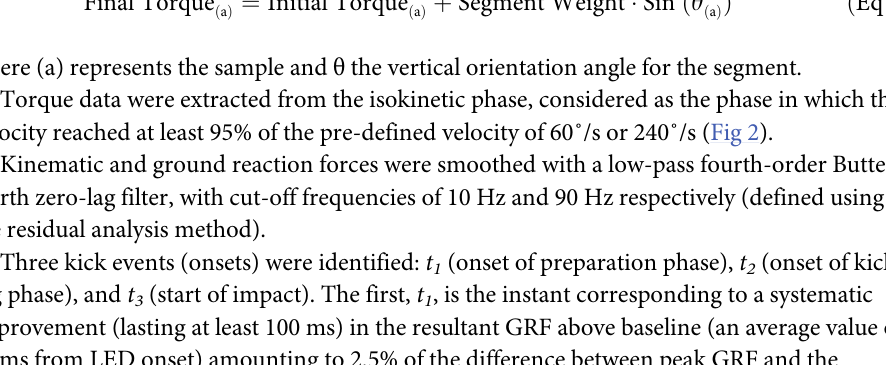
PLOS ONE | https://doi.org/10.1371/journal.pone.0235582 June 9,